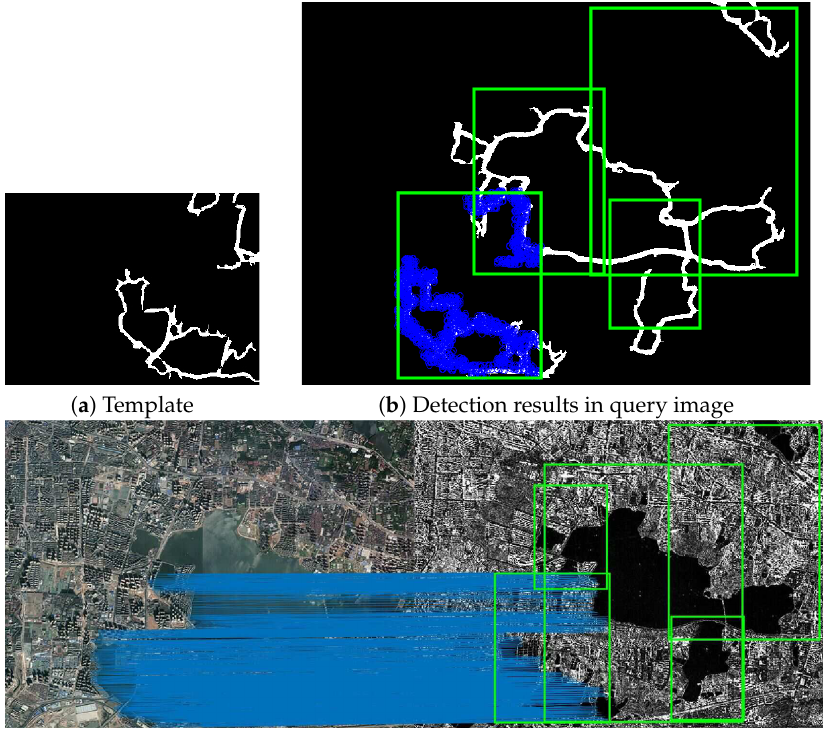
Figure 2. Template matching